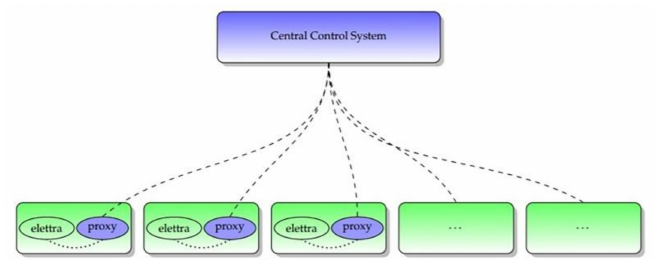
Figure 13. Logic model of the